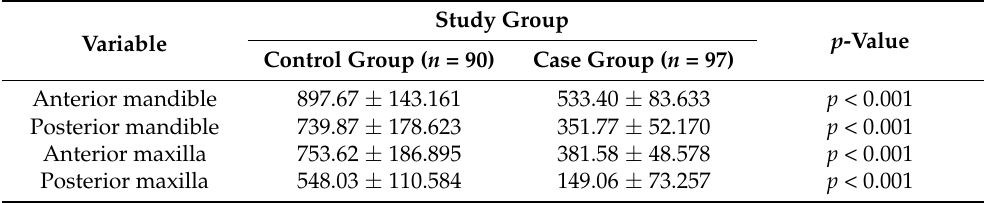
Table 3. Comparative analysis of cone beam computed tomography value variables between the study